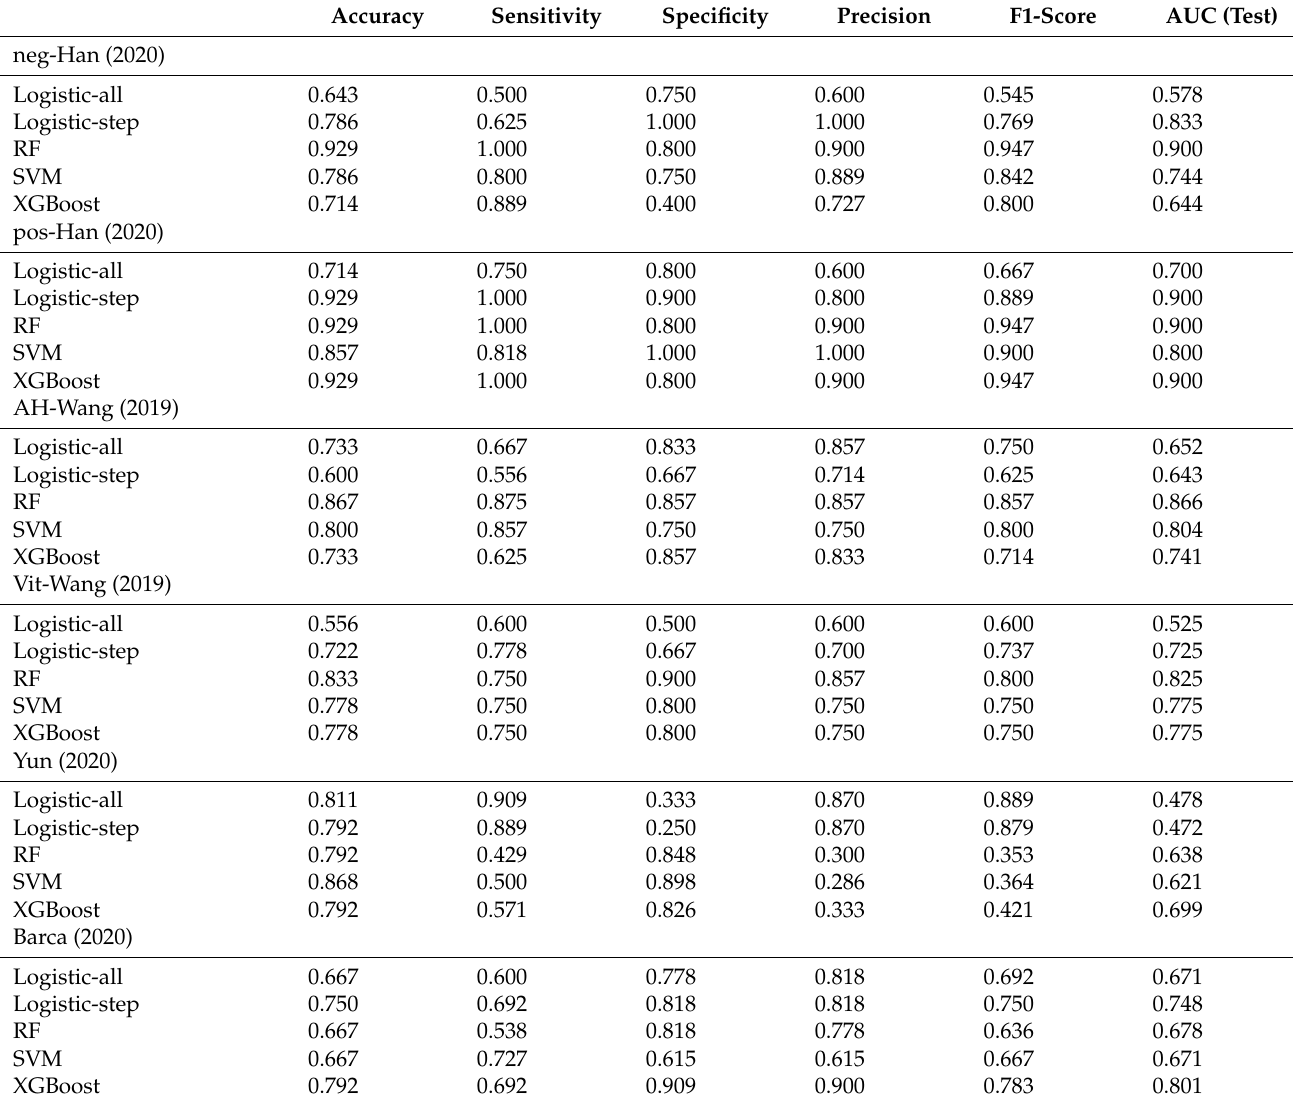
Table 4. Performance of Different